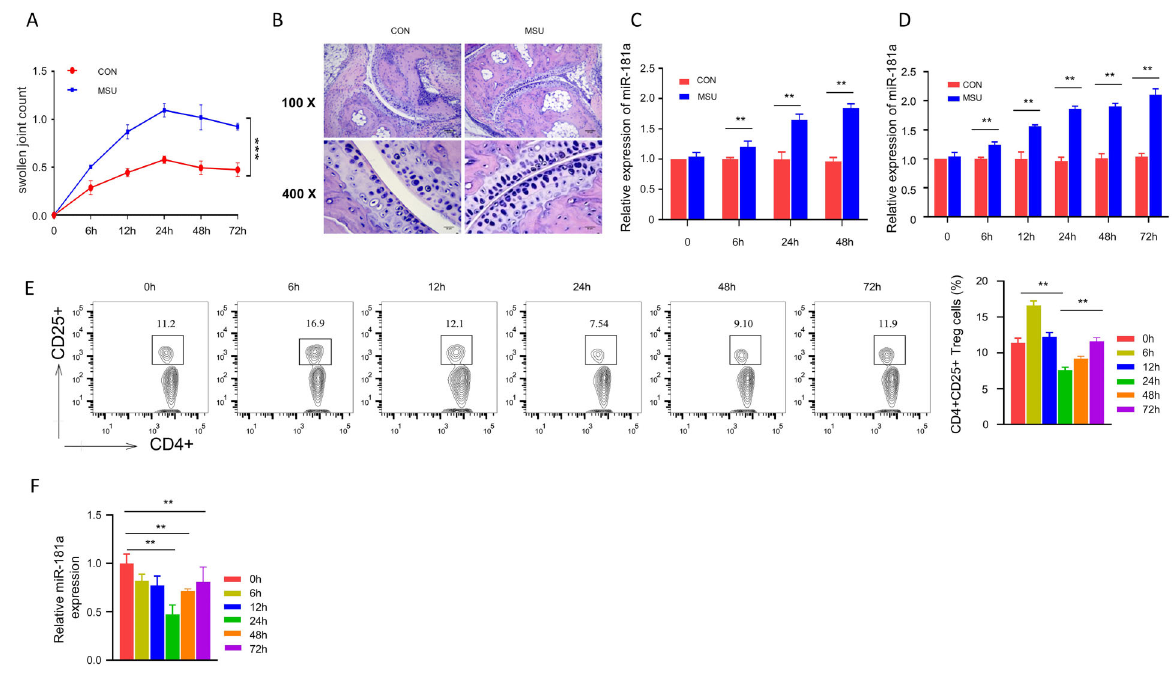
Figure 1. Expression levels of miR-181a in Tregs of acute gouty arthritis (AGA) mice (10 mice per group). A , The clinical scores of ankle joint in monosodium urate (MSU) crystal-induced mice and control (CON) mice were monitored for 72 h after induction. B , Massive in fl ammatory cell in fi ltration was detected within synovial tissues at 12 h by H&E staining (scale bars: 80 m m in upper panels and 20 m m in lower panels). C , Level of miR-181a was measured in joint tissues of MSU and CON mice. D , Expression of miR-181a was measured in Tregs isolated from both groups. E , Percentage of CD4 + CD25 + Treg cells in total CD4 + Tcells was measured by fl ow cytometry at different time points in MSU group. F , miR-181a expression level was quanti fi ed by qRT-PCR in Tregs at different time points after AGA induction. Data are reported as means ± SD. **P o 0.01; ***P o 0.001